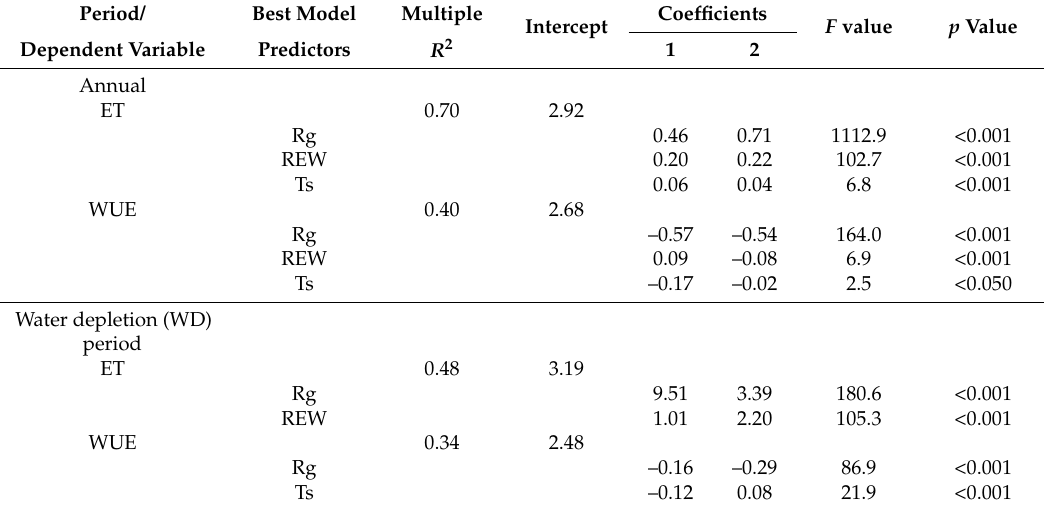
Table 2. Results of the generalized additive model (GAM) analysis done to detect the best models and rank predictor variables (Rg, REW, Ts) according to their ability to explain variations in ET and WUE, annually and during the soil W) period, from 2004–2014. Daily data was used in the analysis. F -values and p -values are statistics given by the GAM